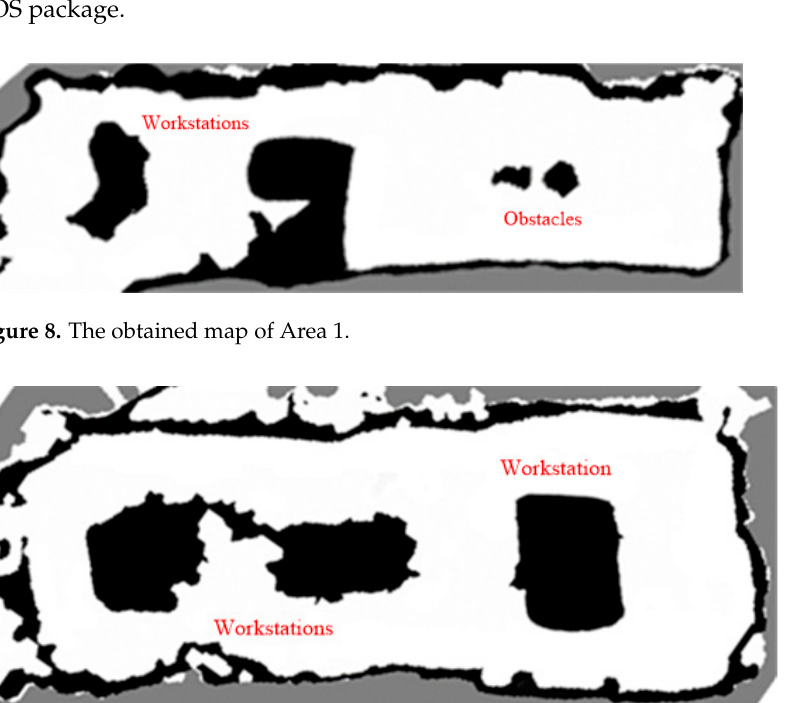
Figure 10. The average map production error for the two areas using Choregraphe and ROS. The robot’s localization accuracy was a critical part of the development of this navi- gation system, since the Pepper robot needs to travel to different, predefined points in